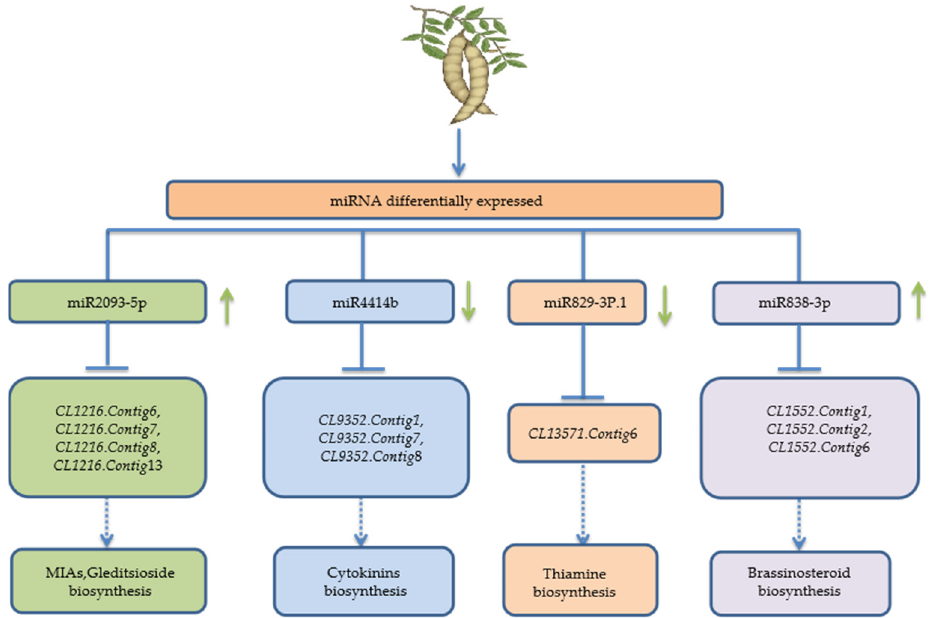
Figure 6. Differential expression of miRNAs in the synthesis of terpenoids of Gleditsia sinensis . Note: The upward arrow indicates upregulation of miRNAs; the downward arrow indicates downregulation of miRNAs, and the dotted arrow represents miRNAs indirectly involved in the synthesis of related terpenoids by inhibiting the expression of target genes.